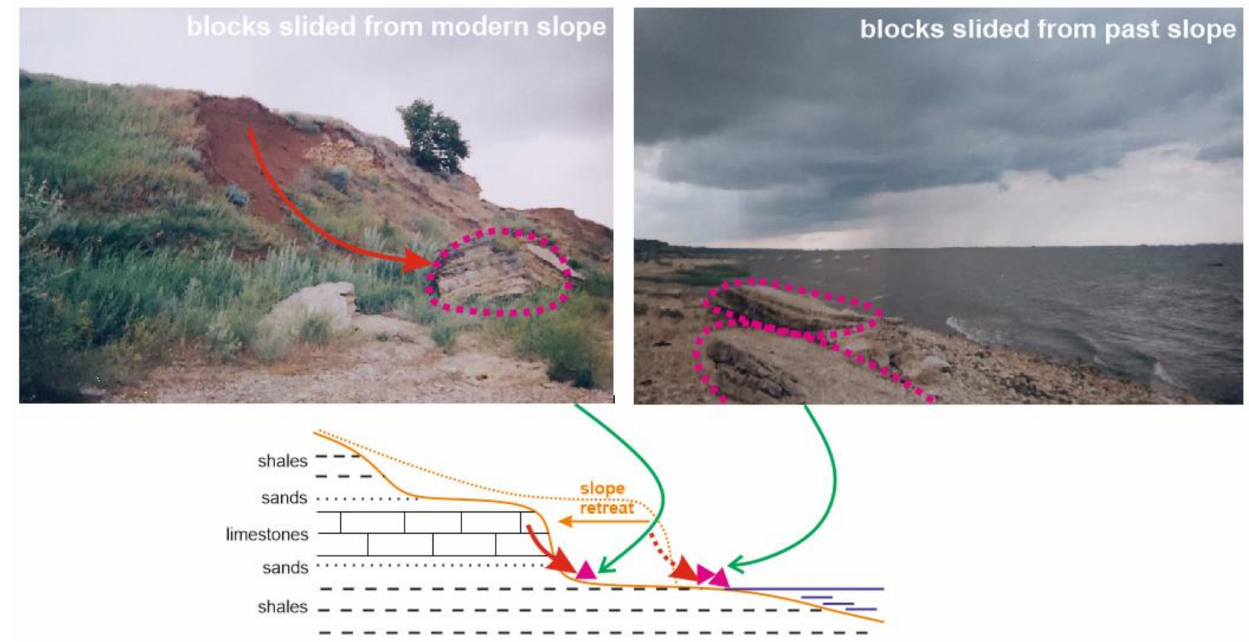
Figure 5. Megaclasts at the Merzhanovo locality (see Figures 2 and 3 for location). Photos by